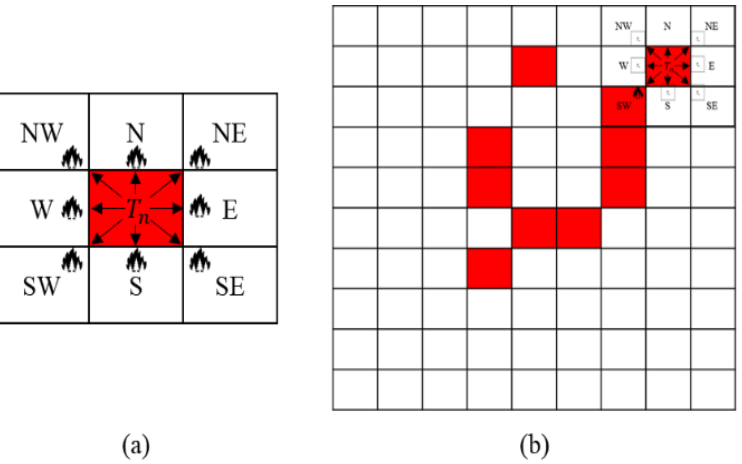
Figure 3. The computing points affected by the neighboring semantic data in a wildfire: ( a ) basic wildfire propagation from one ignition spot to surrounding areas; ( b ) only one spot of a wildfire is insufficient to represent the overall disaster states represented with the red spots and computing loads of a wildfire.